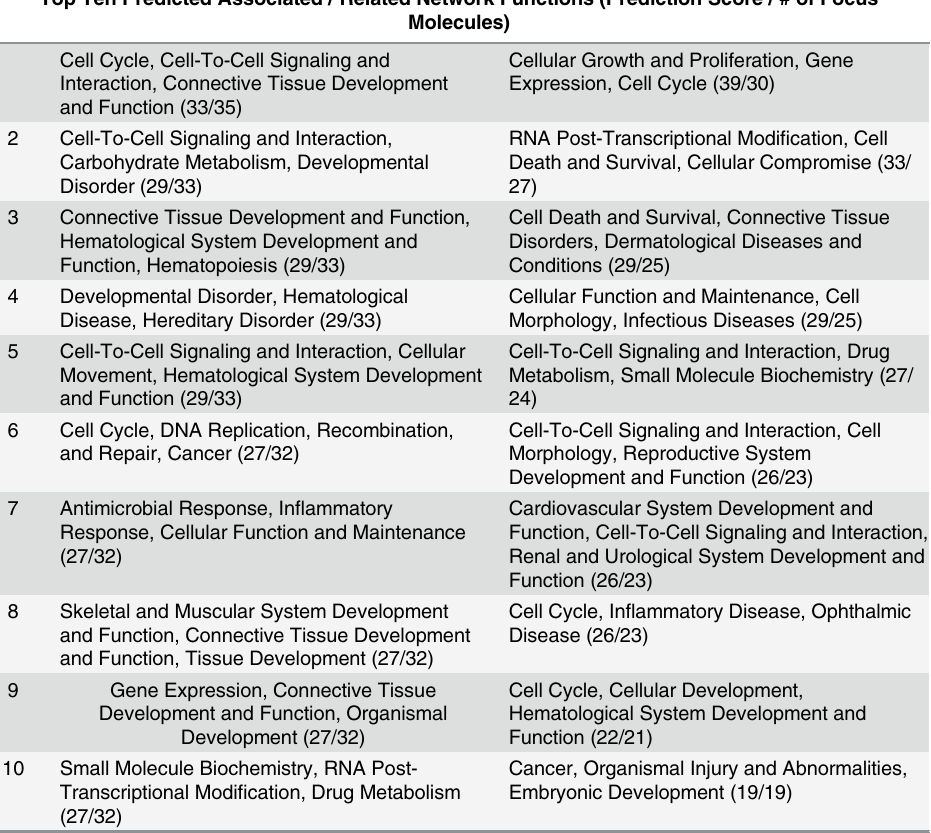
Table 5. Gene Signaling networks of differentially expressed mRNAs and miRNA-mRNA target pairs in the whole blood of workers exposed to MWCNTs. Rank mRNA miRNA-mRNA targets Top Ten Predicted Associated / Related Network Functions (Prediction Score / # of Focus